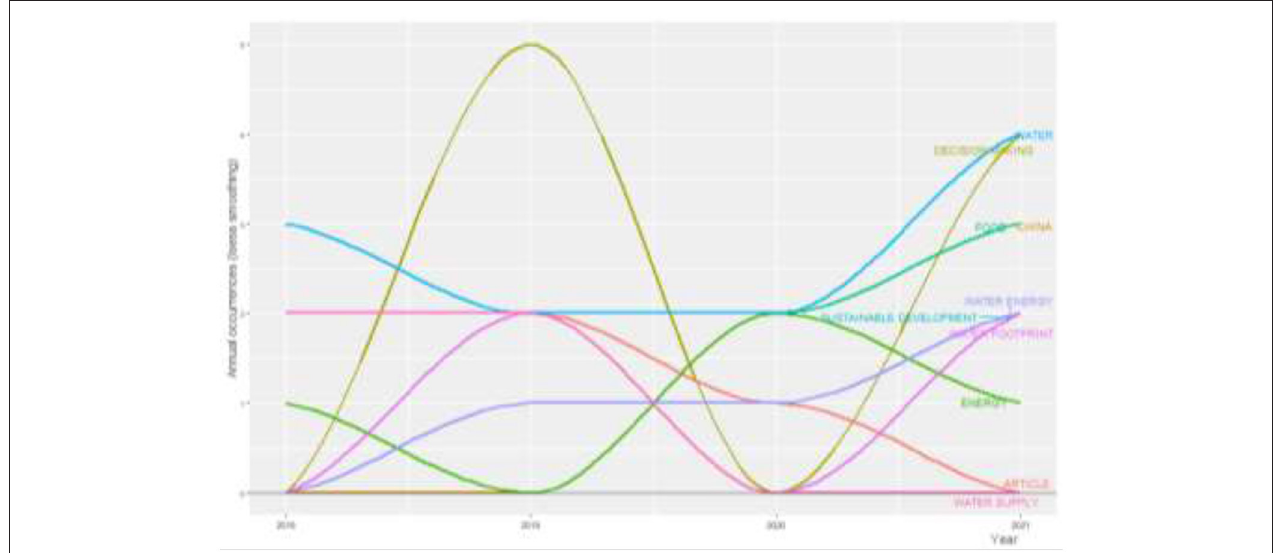
FIGURE 3 | Word dynamics.